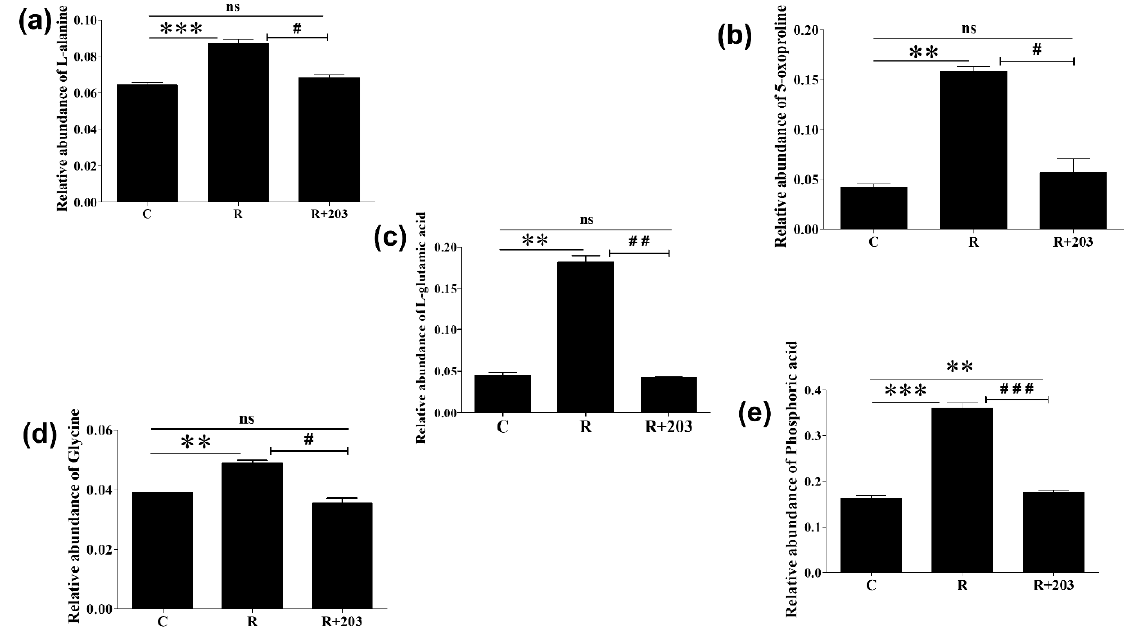
Figure 4. Bar plot showing the relative abundance of—( a ) L-alanine, ( b ) 5-oxoproline (also known as pyroglutamic acid), ( c ) L-glutamic acid, ( d ) glycine, and ( e ) phosphoric acid (Pi)—the metabolites involved in glutathione (GSH) metabolism. All data are presented as mean ± SD ( n = 3) with statistical significance # p ≤ 0.05, **, ## p ≤ 0.005, and ***, ### p ≤ 0.0005.(ns: non-significant, C: imatinib-sensitive K562 cells, R: imatinib-resistant K562 cells, R + 203: hsa-miR-203a-5p transfected imatinib-resistant K562 cells).